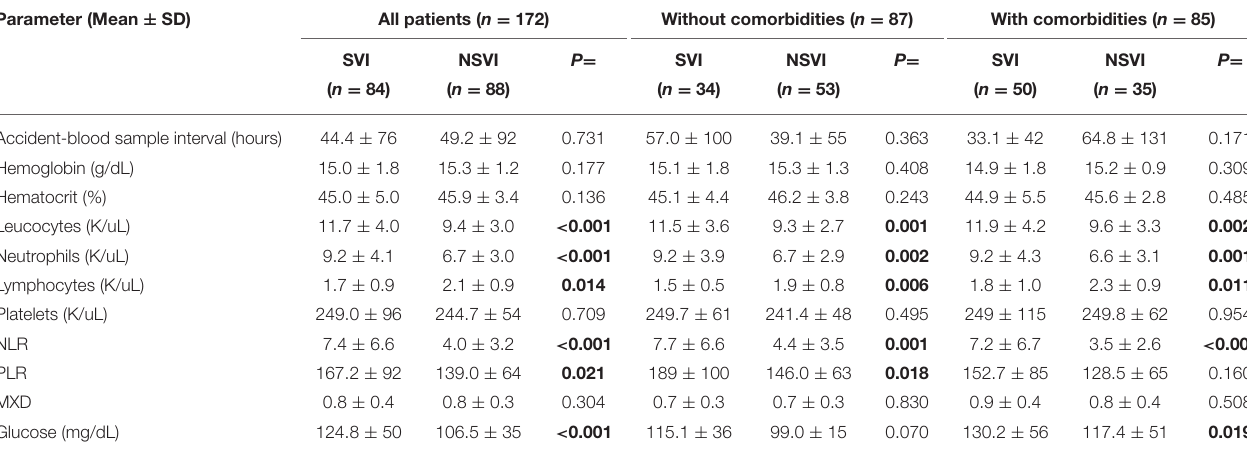
TABLE 3 | Blood test parameters in SVI and NSVI patients with and without comorbidities. Parameter (Mean ± SD) All patients ( n = 172) Without comorbidities ( n =